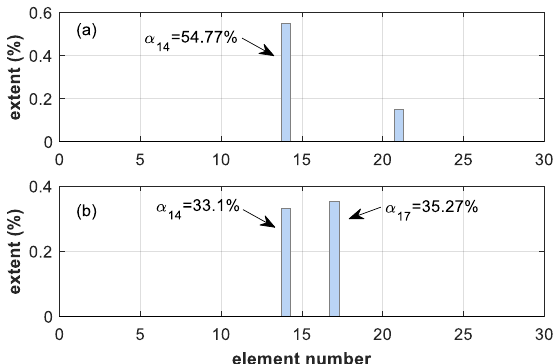
Figure 14. Damage identification results of damage case D at a 3% level of noise, with an iterative Tikhonov solution: ( a ) CMSE method; ( b ) RCMSE method. Tikhonov solution: ( a ) CMSE method; ( b ) RCMSE